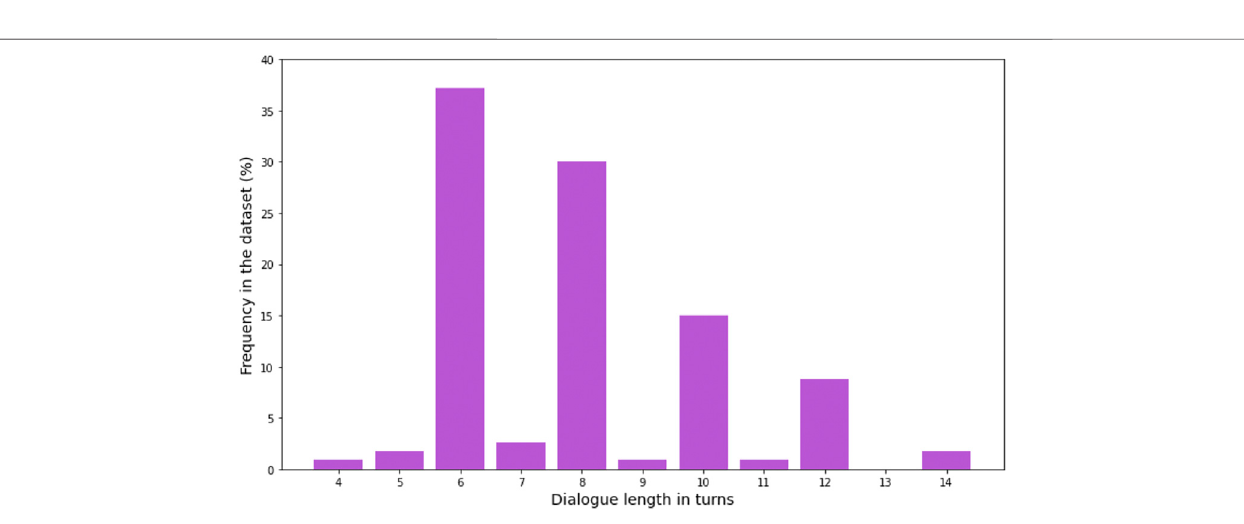
FIGURE 8 | Distribution of dialogue length in number of turns in